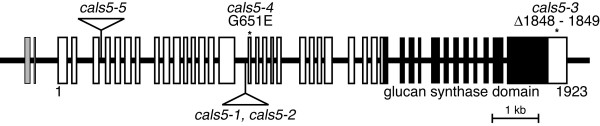
CALS5 mutations. The CALS5 5769 bp open reading frame encodes a predicted protein measuring 1923 amino acids. Boxes, exons; filled boxes, similar to domains in glycogen synthase; gray boxes, 5' untranslated region. cals5-3 is a deletion of amino acids 1848–1849; cals5-4, a G651E substitution; cals5-1, cals5-2 and cals5-5, T-DNA insertions.